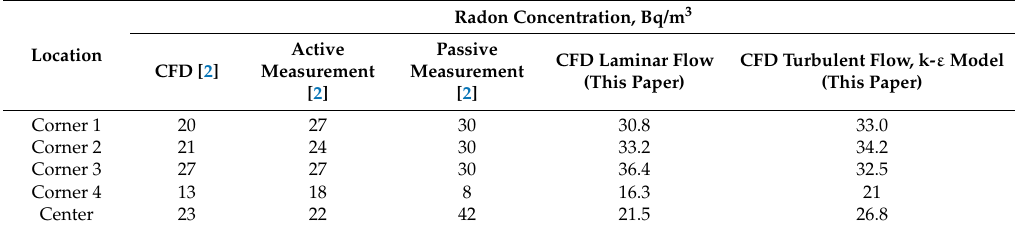
Table 1. Comparison of simulation results with study [2]; radon concentration at z = 1.22 m. CFD: computational fluid dynamics.